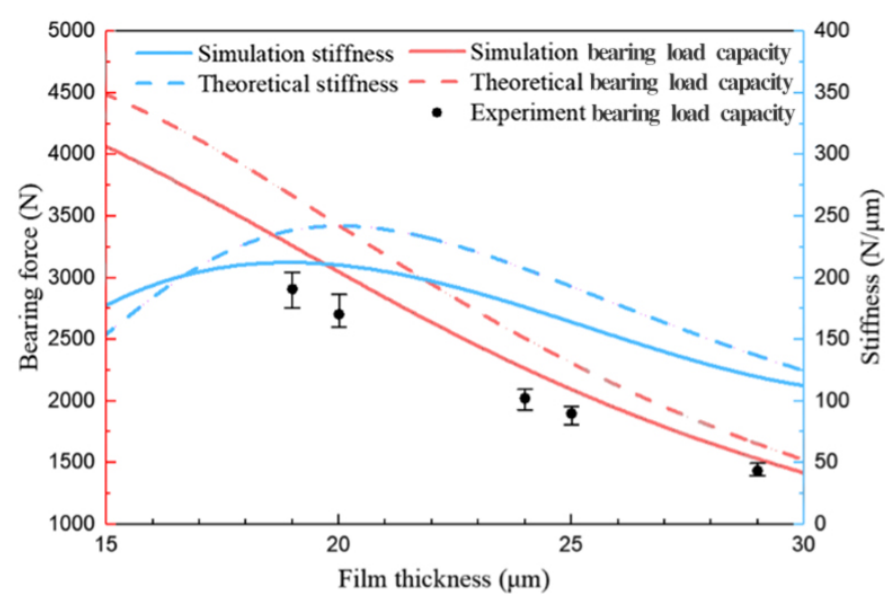
Figure 7. The results of theoretical calculation, simulation and experimentation for supporting load capacity and